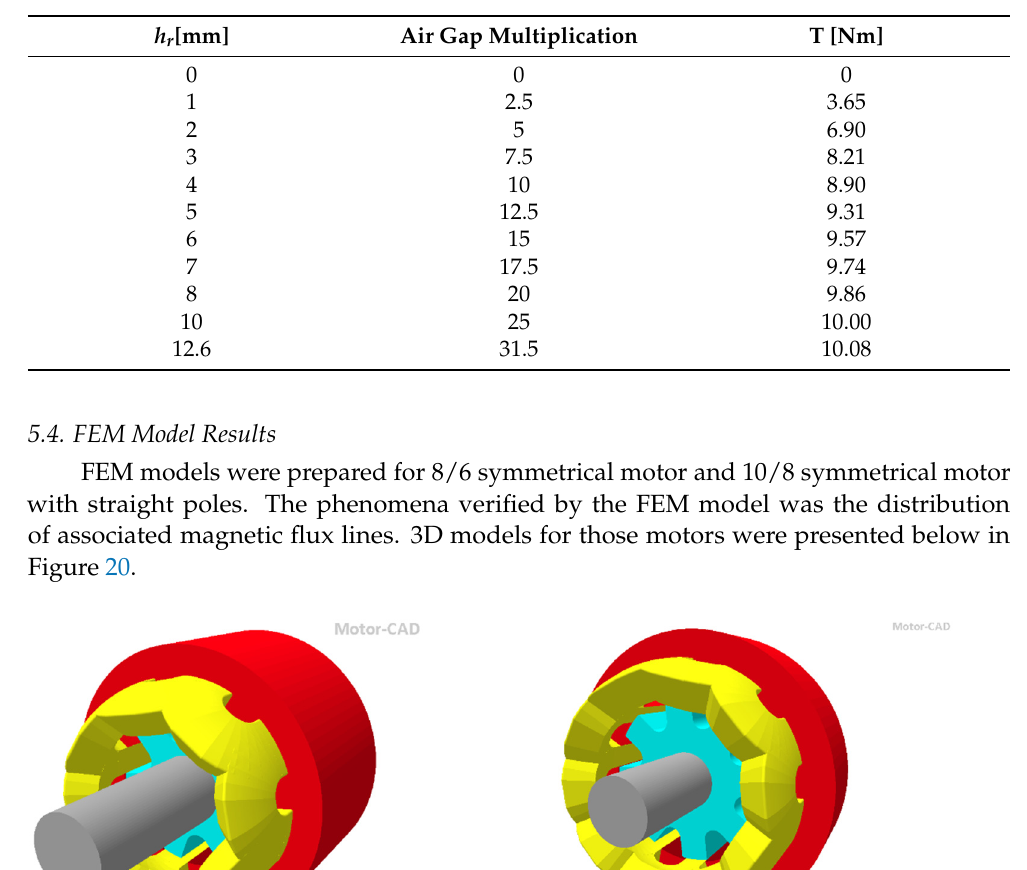
Figure 19. Characteristics of the maximum torque as a function of the height of the rotor pole obtained as a result of calculations using the finite element method. Table 2. The results of the study of the influence of the rotor pole height h r on the moment.